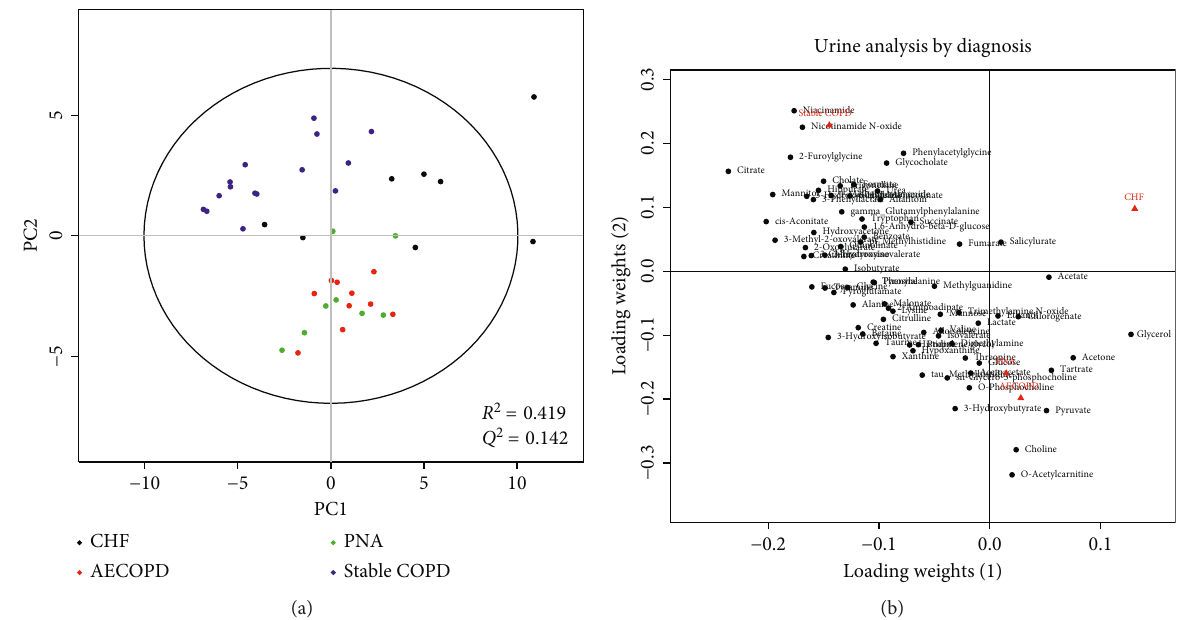
Figure 2: PLS-DA score plots (a) and loading plots (b) of urine samples drawn from patients with stable COPD (blue), AECOPD (red), CHF (black), or PNA (green). Each circle represents a urine sample. Some separation between the groups can be seen. The loading plot shows how the profiled metabolites contribute to the separation seen in the scores. The model is statistically significant ( p < 0 . 001), but the fit is moderate at best ( R 2 (cid:136) 0.419) with moderate predictive value ( Q 2 (cid:136) 0.142). Taken with the rest of the results, our interpretation is that the separation is likely due to the presence of respiratory failure. Table 2: Concentration (millimolar) of the top 10VIP metabolites in serum of subjects with stable COPD, AECOPD, CHF, and PNA. Stable COPD ( n (cid:136)